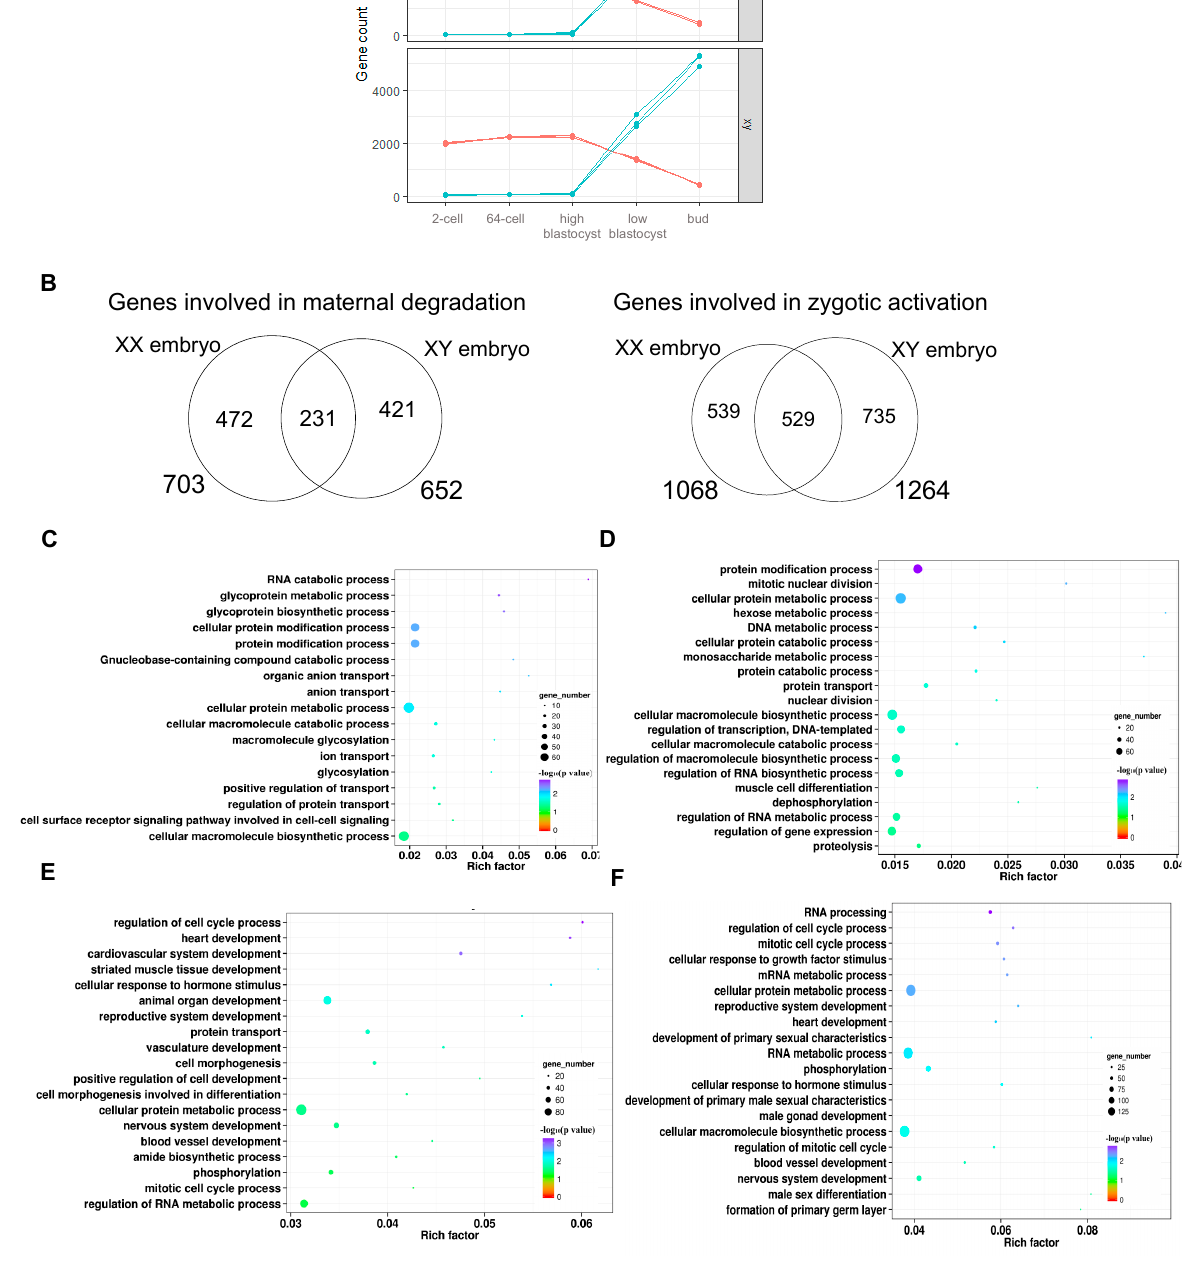
Figure 5. Identification of maternal and zygotic SNPs and genes from maternal-to-zygotic transition. ( A ) Maternal and zygotic expressed genes were detected at the low-blastocyst stage of both XX all-female and XY all-male yellow catfish. ( B ) Overlap of maternal degradation genes between XX all-female and XY all-male yellow catfish (left), and overlap of zygotic activation genes between XX all-female and XY all-male yellow catfish (right). ( C ) Function enrichment of maternal degradation genes from XX all-female. ( D ) Function enrichment of maternal degradation genes from XY all-male. ( E ) Function enrichment of zygotic activation genes from XX all-female. ( F ) Function enrichment of zygotic activation genes from XY all-male.